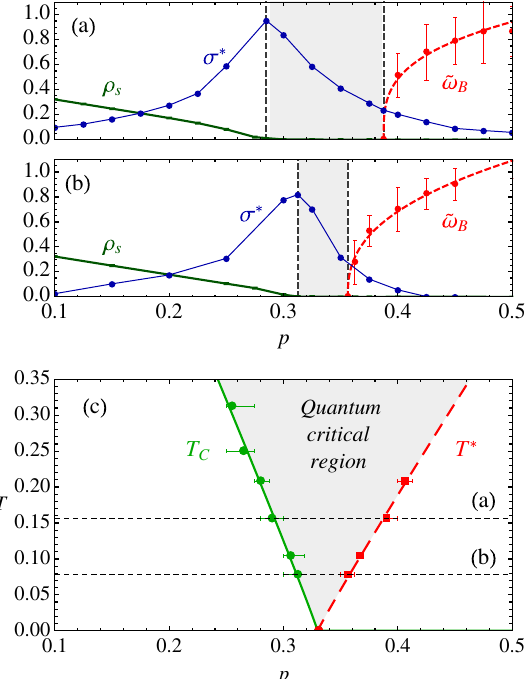
FIG. 5. (a),(b) Superfluid stiffness ρ s (green line), bosonic scale ~ ω B (red line) in the insulator, and low-frequency conductivity (blue line), defined in the text, as functions of disorder p at two different temperatures shown in (c). The quantities are in units of E J and σ Q ¼ 4 e 2 =h , respectively. The quantum critical region is shaded gray in all three panels. (c) Phase diagram with T c determined by the vanishing of ρ s and T (cid:1) by the vanishing of ~ ω B . The lines are fits to j p − p c j z ν with p c ≈ 0 . 337 and z ν ≈ 0 . 96 .